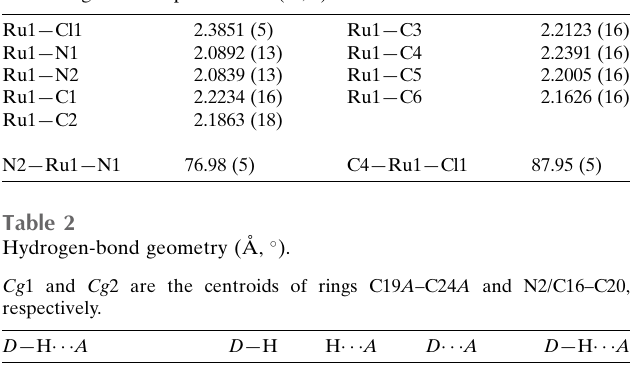
Table 1 Selected geometric parameters (A˚ , (cid:5) ).